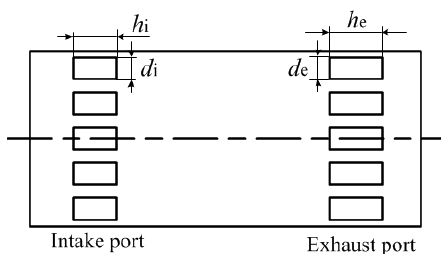
Figure 2. The port parameters.